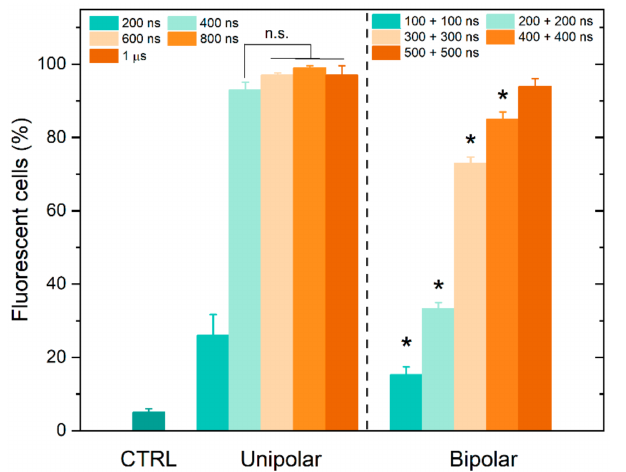
Figure 8. Cell permeabilization triggered by single unipolar and bipolar pulses of 20 kV/cm, where the asterisk (*) corresponds to statistically significant ( p < 0.05) differences between unipolar and bipolar pulses of identical energy; n.s.—statistically non-significant ( p >